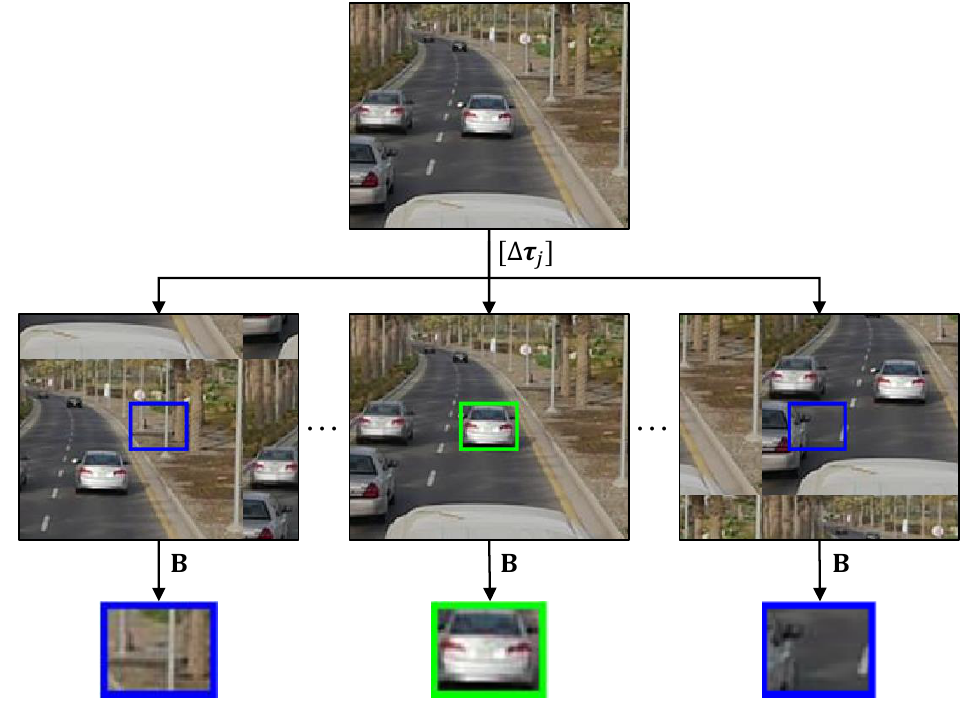
Figure 3. Tracker with background-aware correlation filter is trained with real negative